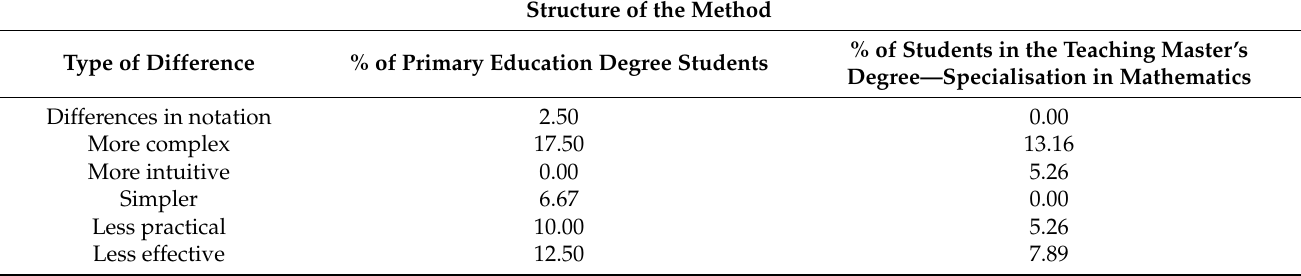
Table 1. Differences found between the degree and the master’s students, regarding the structure of the multiplica- tion method.